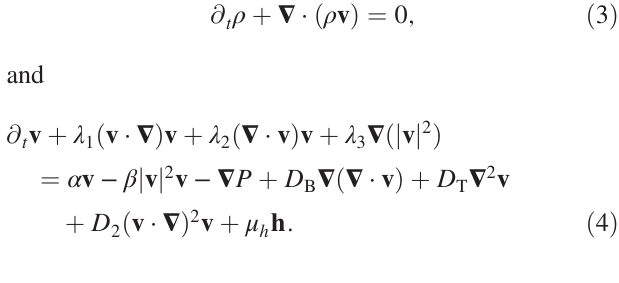
W ¼ 0 . 5 , 0.25, 0.175 mm. The values of h are is defined by the wavelength where B is maximal. (c) Variations B with j h j . The bending B ð W Þ for the three experiments. The error bars c